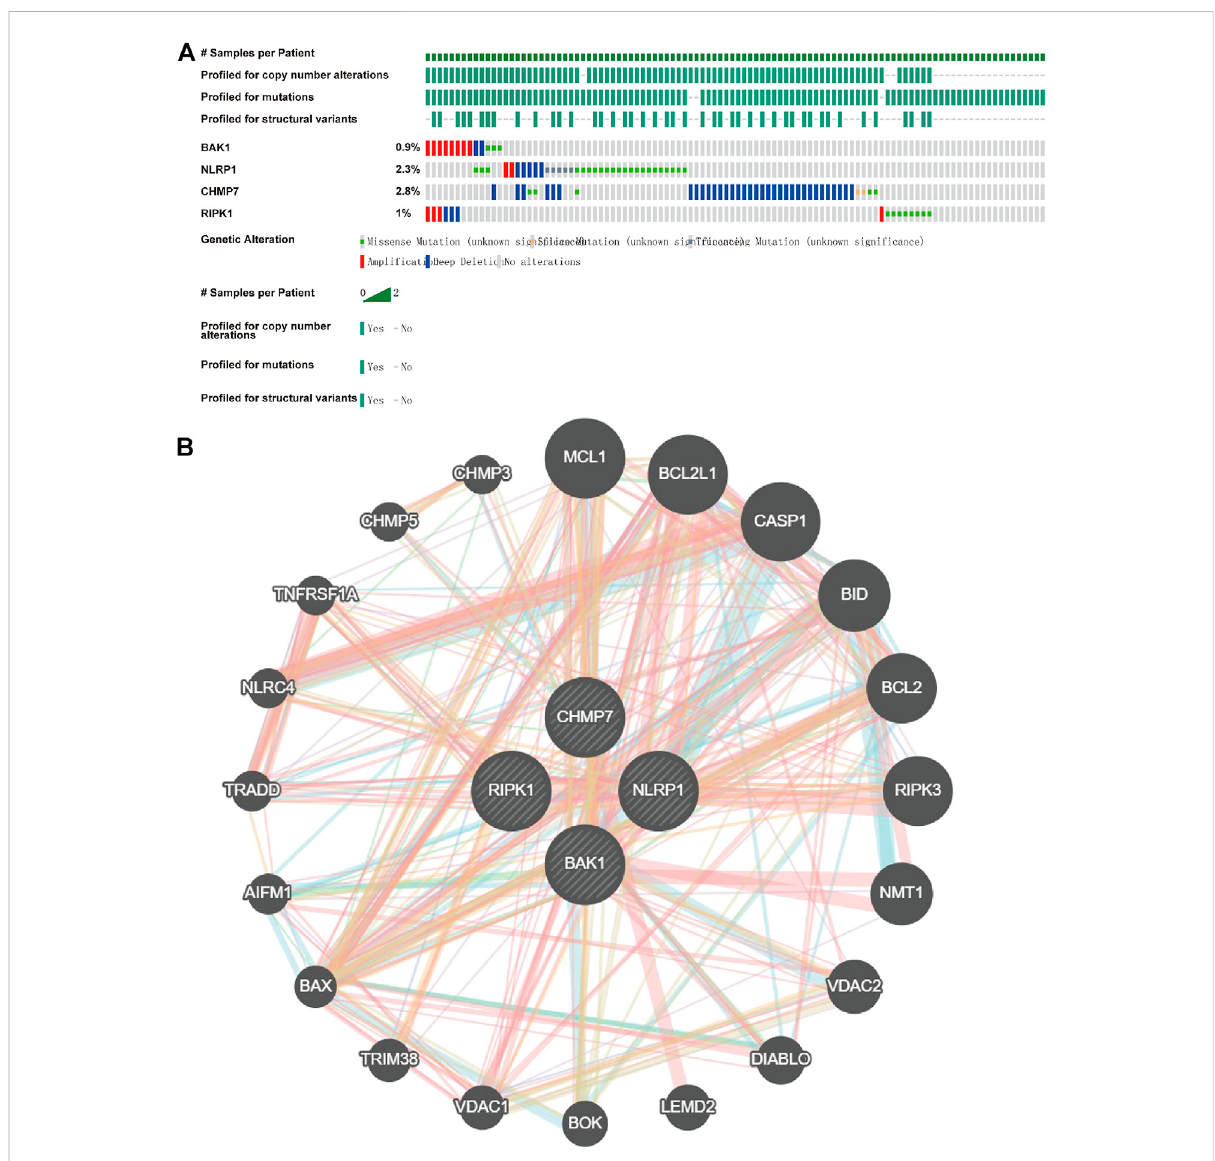
FIGURE 6 Mutationsof BAK1 , NLRP1 , CHMP7 , and RIPK1 genes in head and neck squamous cell carcinoma (HNSCC) and their interplay network. (A) Total mutations of BAK1, NLRP1, CHMP7, and RIPK1 in HNSCC; (B) GeneMANIA demonstrates the gene interaction network of BAK1 , NLRP1 , CHMP7 , and RIPK1